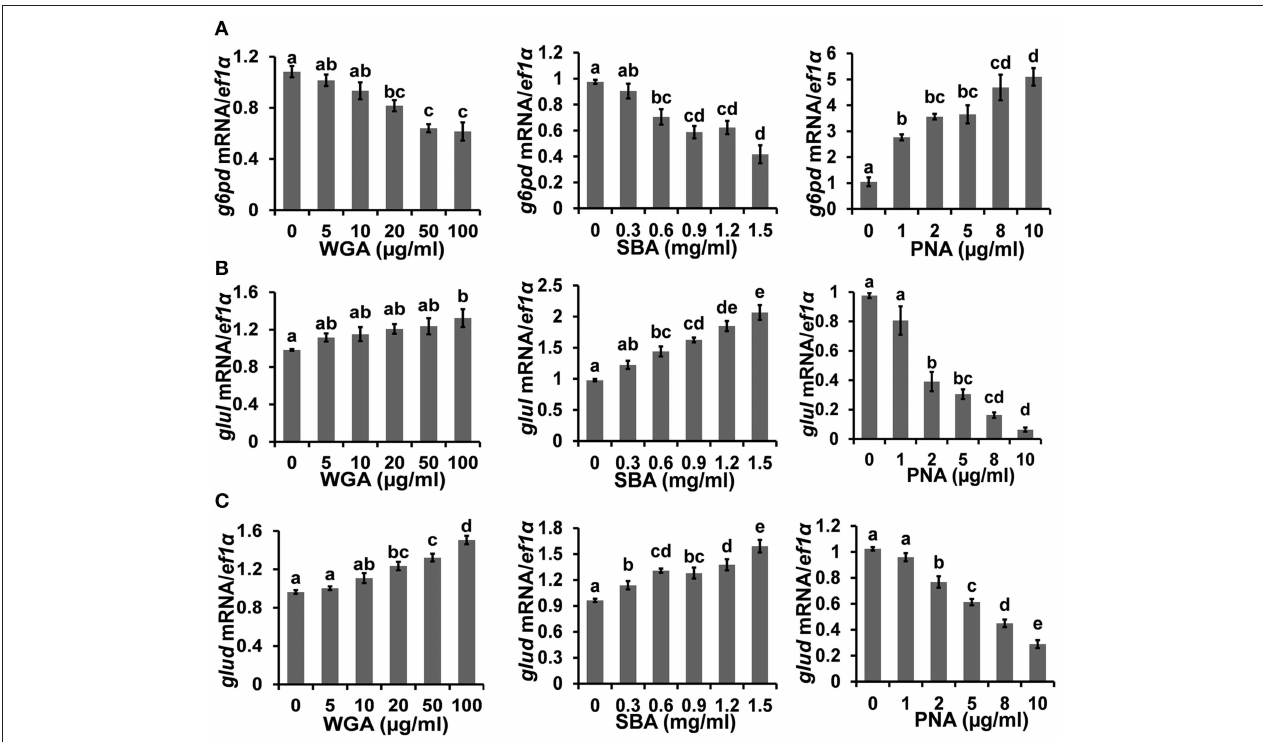
FIGURE 4 | The influence of lectins on cellular metabolism. The mRNA expressions of (A) g6pd , (B) glul , and (C) glud , were analyzed by quantitative real-time PCR after lectins treatments. Results were represented as means with standard errors ( n = 6) and analyzed using One-Way ANOVA. Values with different letters in the same column (a–e) were significantly different ( p < 0.05) from each other.